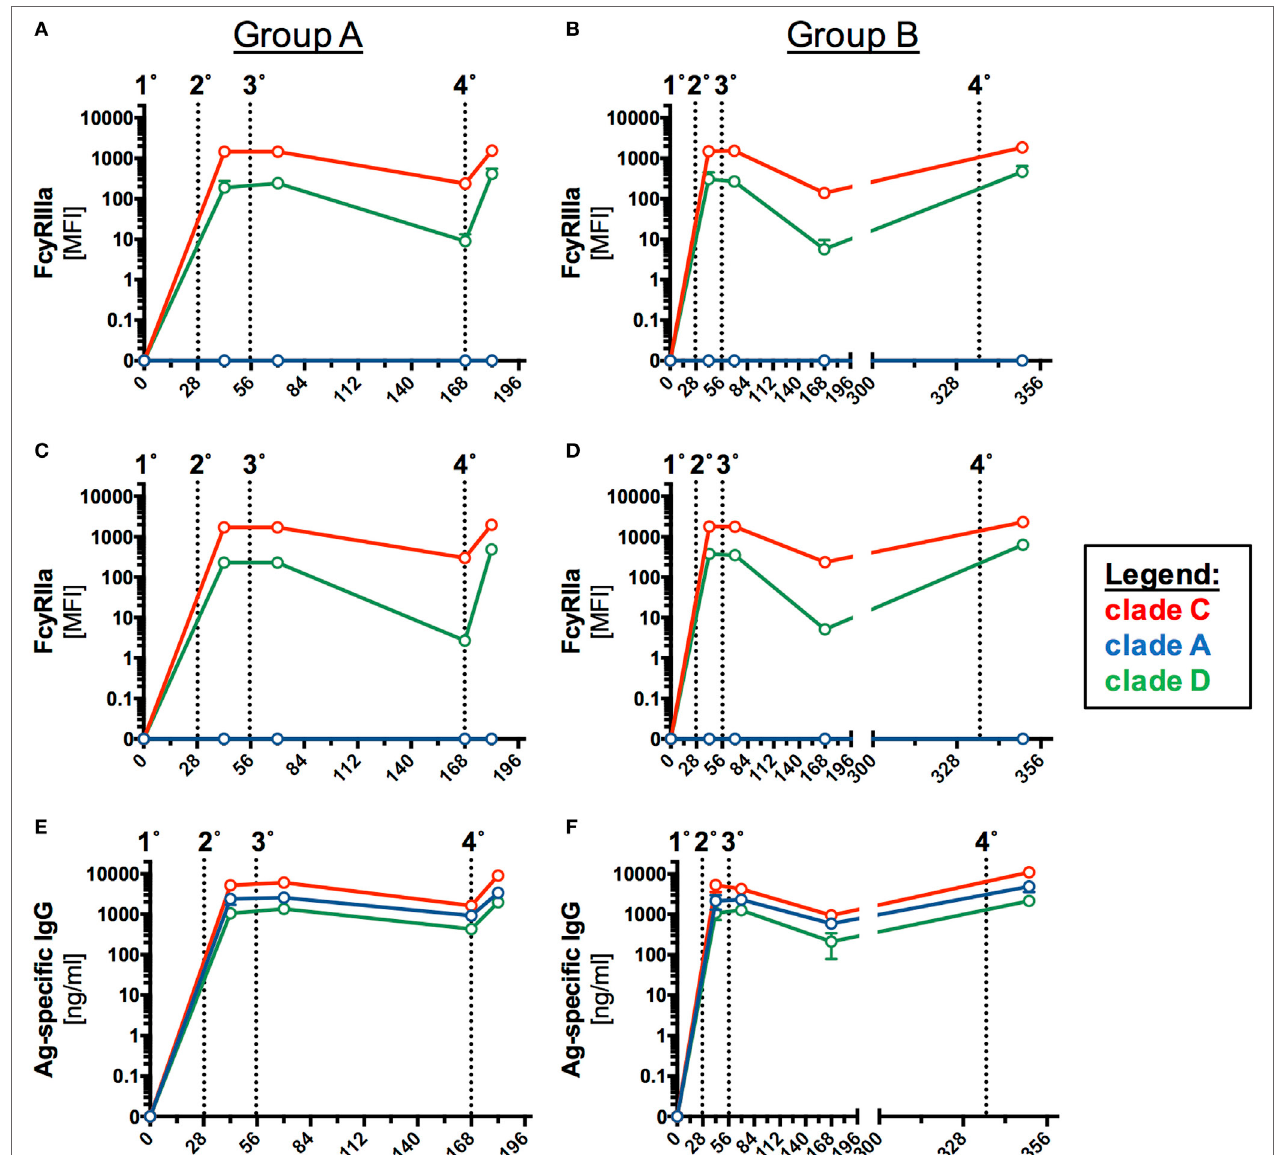
FiGUre 5 | Fc γ r-binding profiles and breadth of antigen (ag)-specific humoral responses in serum samples following homologous prime-boost immunization . The ability of vaccine-induced antibodies recognizing clade C.CN54gp140, A.UG37gp140, and D.UG21gp140 human immunodeficiency virus (HIV) proteins to bind dimeric (a,B) Fc γ RIIIa or (C,D) Fc γ RIIa was assessed in a customized multiplex dimer assay. (e,F) For further comparison, HIV-binding antibodies (e,F) were determined for the three selected clades for both study groups (A, n = 6 and B, n =